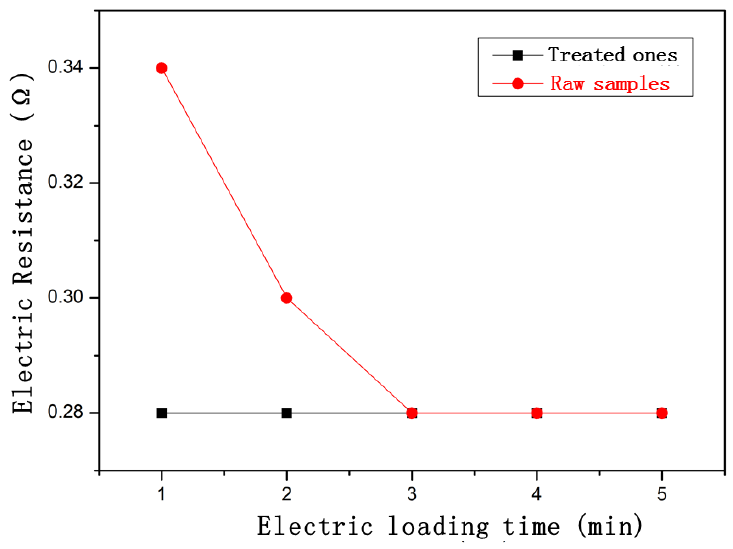
Figure 10. Resistance response of CFRE sheets before and after saturated moisture absorption.